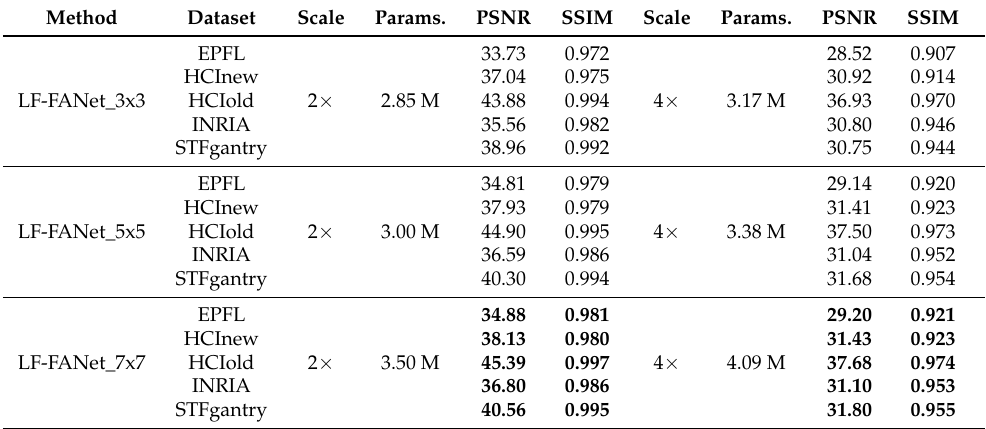
Table 6. Comparative results of different angular resolutions on the testing datasets using our LF-FANet for 2 × and 4 × LFSR.The best results are in